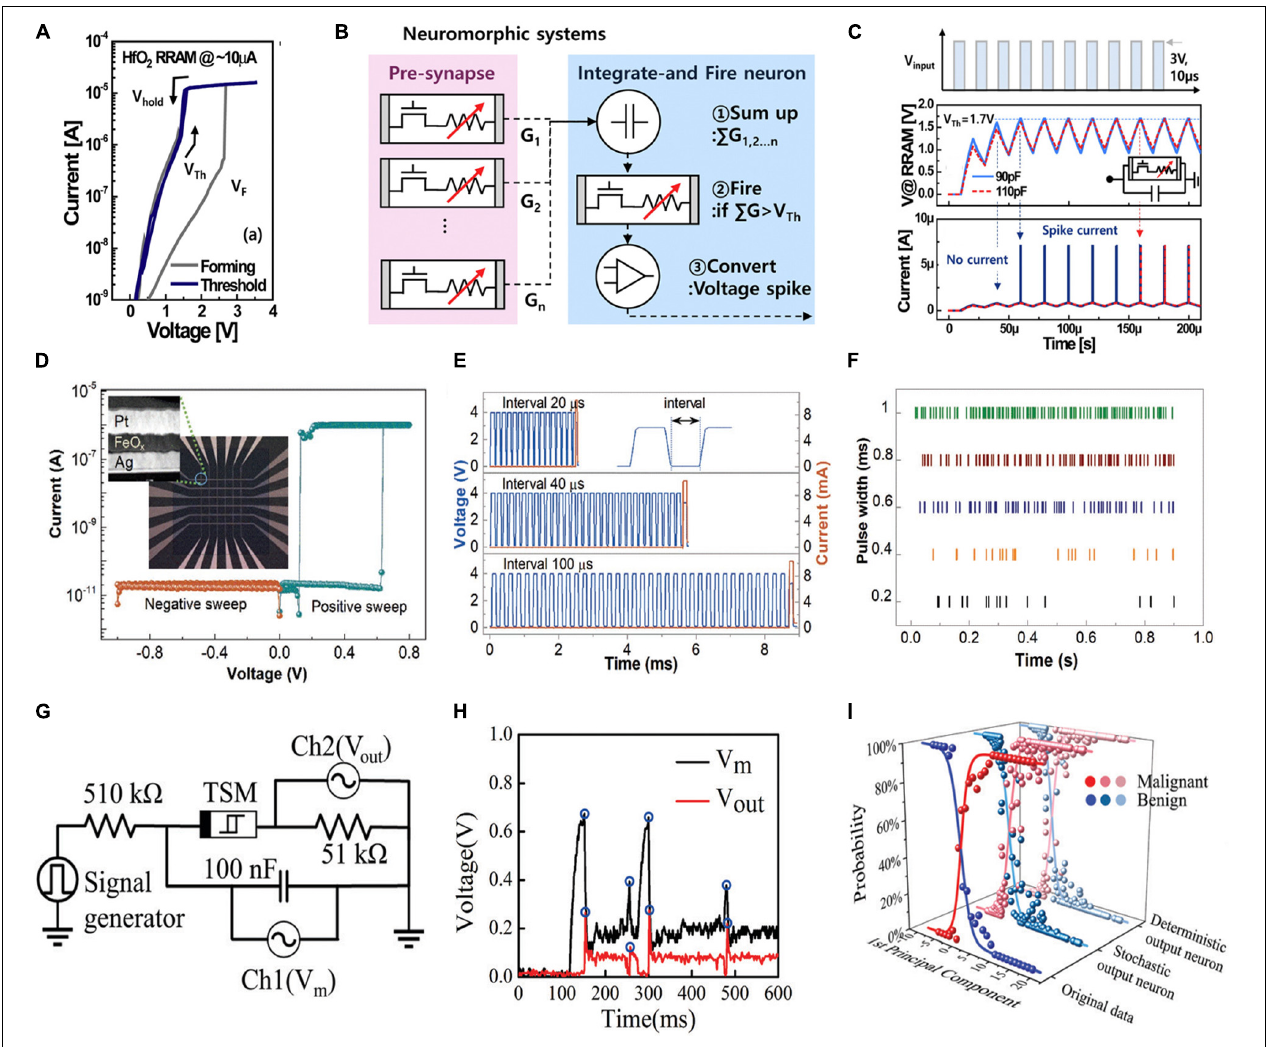
FIGURE 4 | (A) Threshold switching (TS) characteristics of the valence change mechanism (VCM) cell at a compliance current of 10 µ A. (B) Schematic of the neuromorphic system comprising neurons and synapse elements. (C) Output dynamics of VCM-based artificial neuron (Woo et al., 2017). (D) Volatile-switching behavior of Pt/FeO 3 /Ag device. Inset shows multiple cells with cross-bar structure and the cross-section view of one device under high-resolution transmission electron microscopy inspection. (E) Dependence of integrate-and-fire on the input pulse interval. (F) Raster plot of firing patterns with respect to time for a memristive neuron with 10 M (cid:127) in series on a dedicated circuit board (Zhang et al., 2018). (G) Schematic of a neuronal circuit with the input voltage pulses originating from the signal generator. (H) Measured stochastic spike events of the CuS/GeSe-based neuronal circuit. (I) Comparison of the output probability of deterministic and stochastic neurons (Wang et al.,